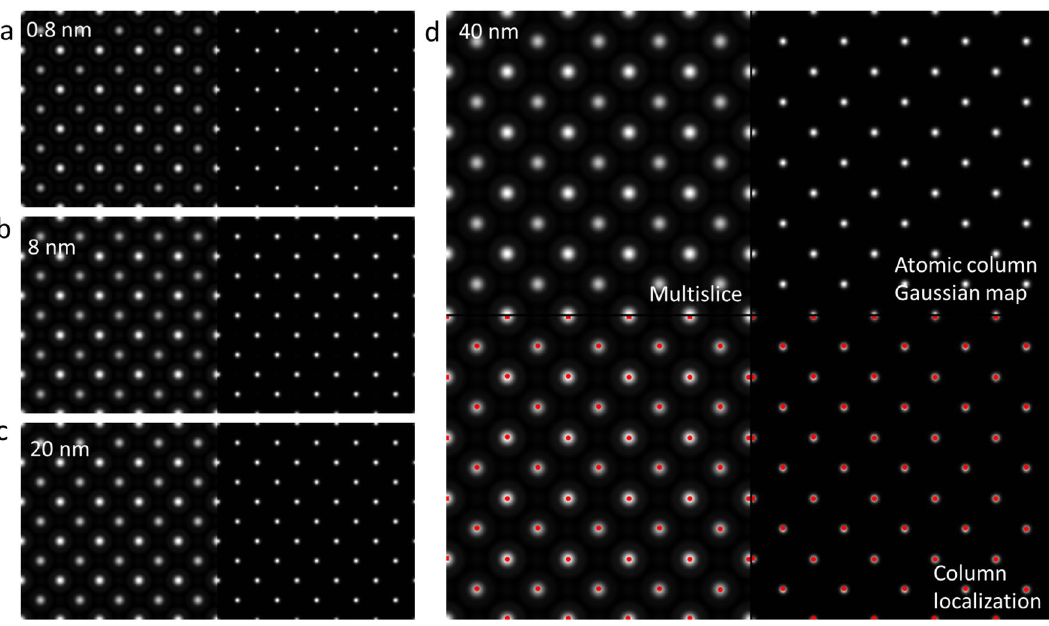
Figure 7. Simulated ADF-SETM images of SrTiO3 along the [001] zone axis and the results processed by the atomic column Gaussian mapping model (200 keV, α max = 20 mrad, df = 80 angstrom, C 3 = 0.0257 mm, collection angles: 98–196 mrad. Here, the defocus is deliberately chosen slightly off from the optimal value so the halo around the peak is